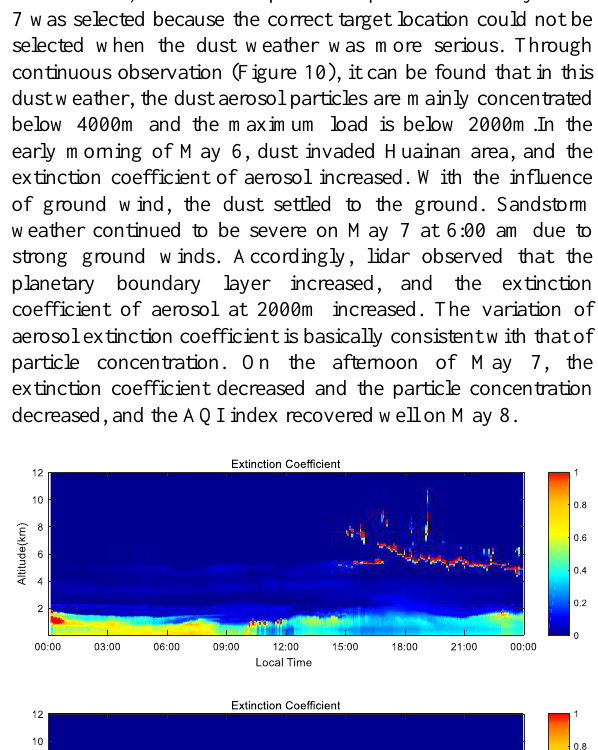
Figure 8. Vertical temperature profile during the dust pollution